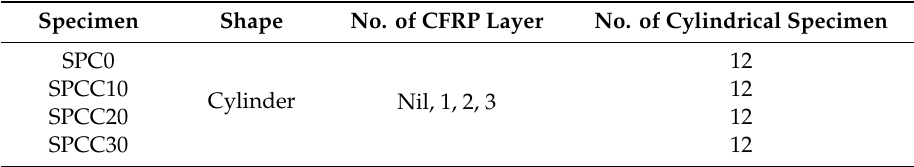
Table 7. The number of test cylinders with a di ff erent number of CFRP